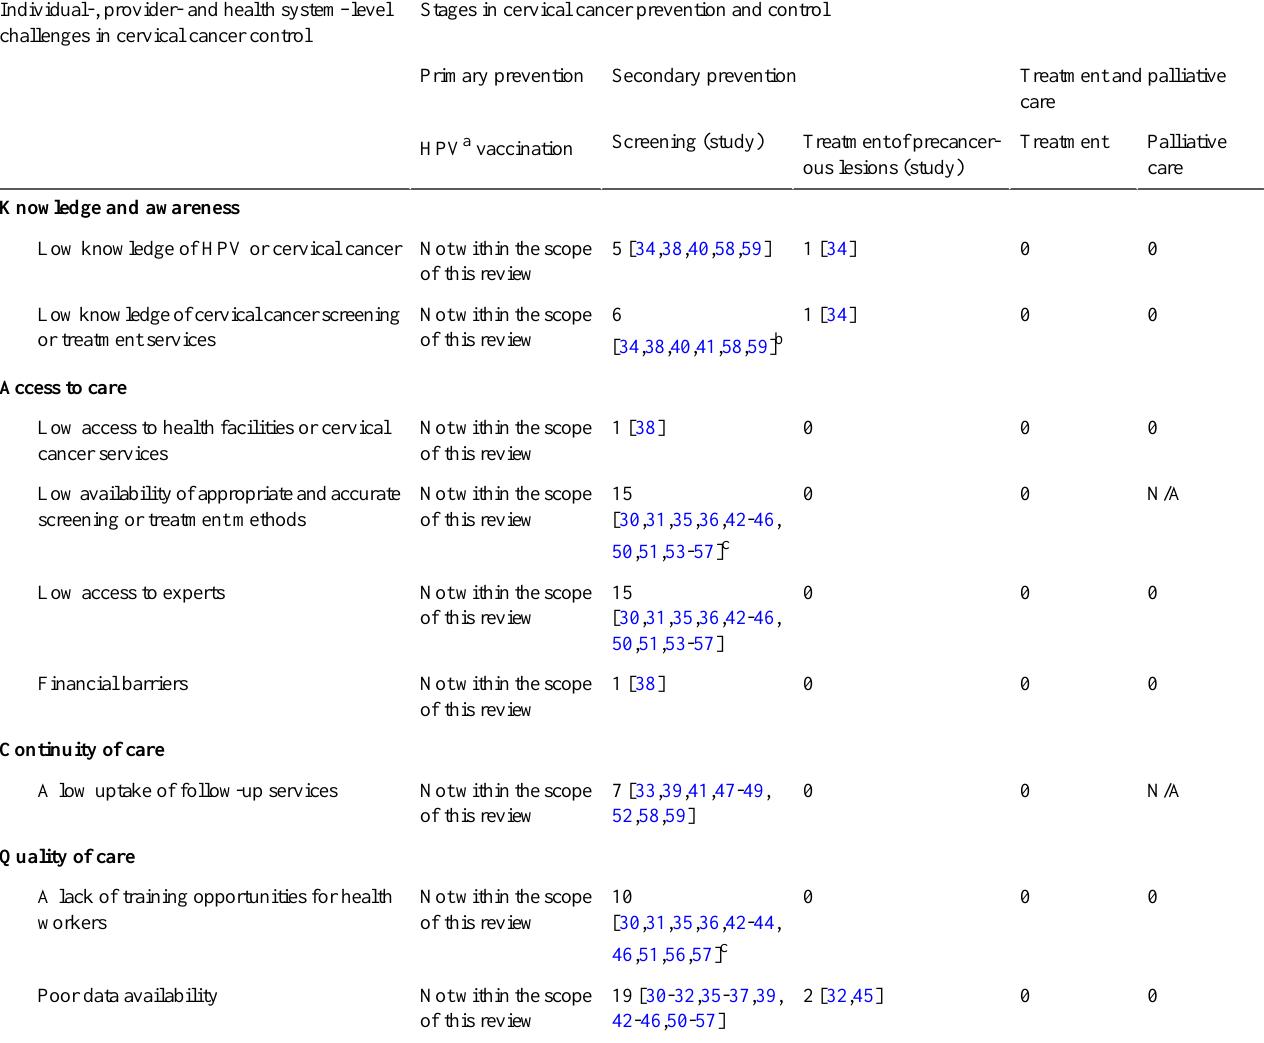
Table 3. Landscape of digital health strategies for cervical cancer prevention and